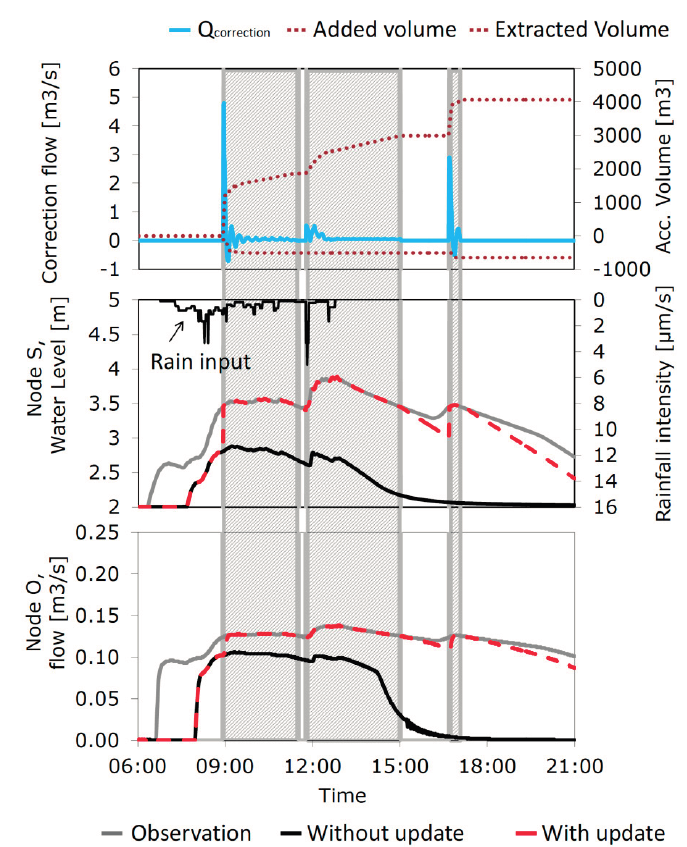
shown. Both the observed and simulated water levels with and without updating are